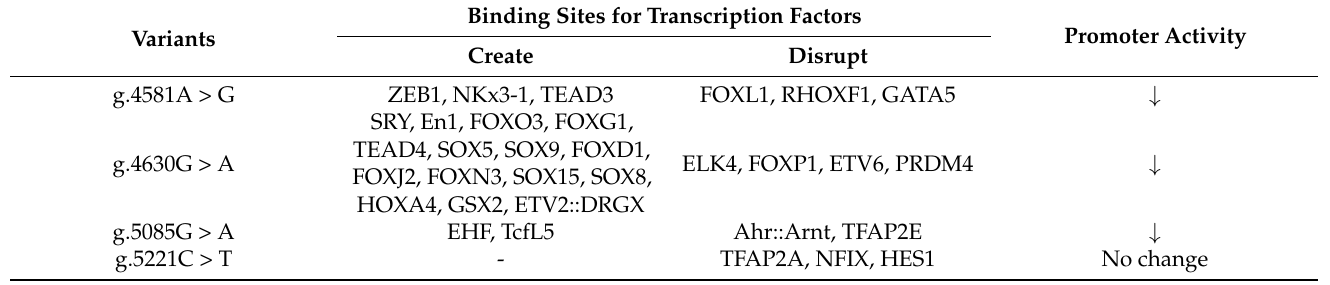
Table 3. Predicted binding sites for transcription factors and promoter activity affected by variants.